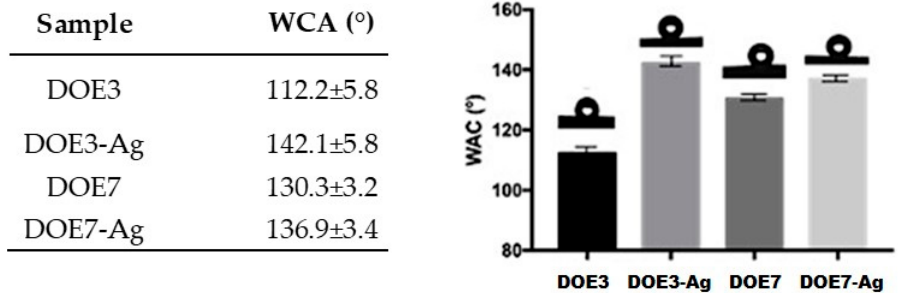
Figure 10. Water contact angle values (WCA) (mean ± standard deviation) on PSU and PSU-Ag